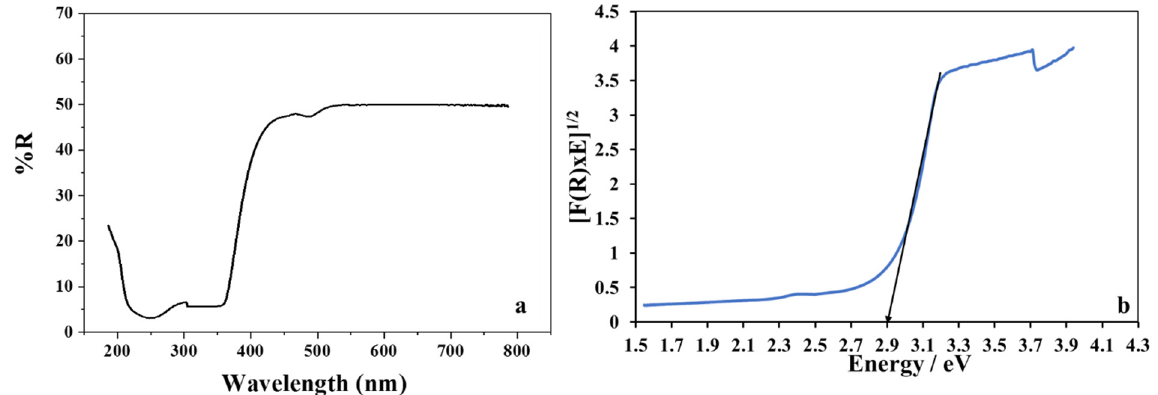
Figure 3. ( a ) Diffuse reflectance spectrum for % reflectance of ZnO/CuO and ( b ) band gap energy for ZnO/CuO.